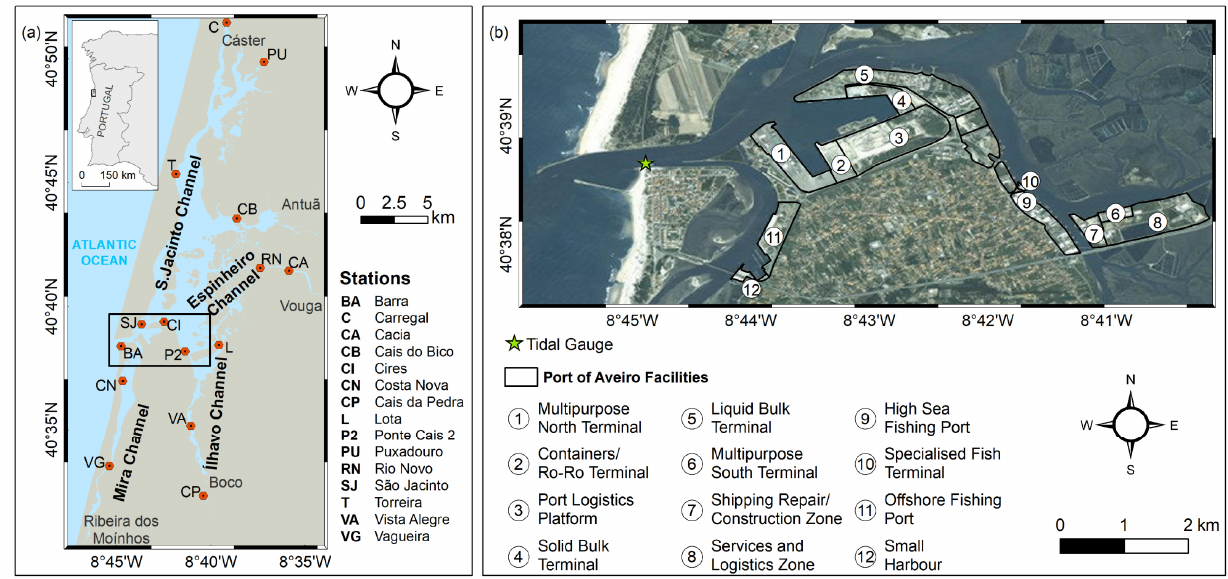
Figure 4. Location of the Aveiro port ( a ) and the business areas in the port administration jurisdic- tion ( b )